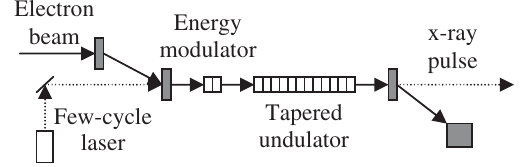
FIG. 1. Main components of the tapered undulator scheme.